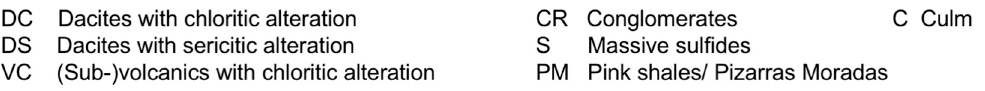
Figure 10. 3D hypercloud display of three individual HSI image scenes overlain on photogrammetric RGB point cloud of the Corta Atalaya open pit. All three scenes were used for Minimum Wavelength Position Mapping to highlight lithological variations associated with differences in the abundance of AlOH-bearing minerals. The white rectangle marks the area shown in Figure 11. The colour differences in the MWL hypercloud show excellent correlation with the known main lithologies and alteration zones [28]. Zones not described in [28] are indicated with question marks. Sample locations for Figure 11b are marked with white circles and numbers.